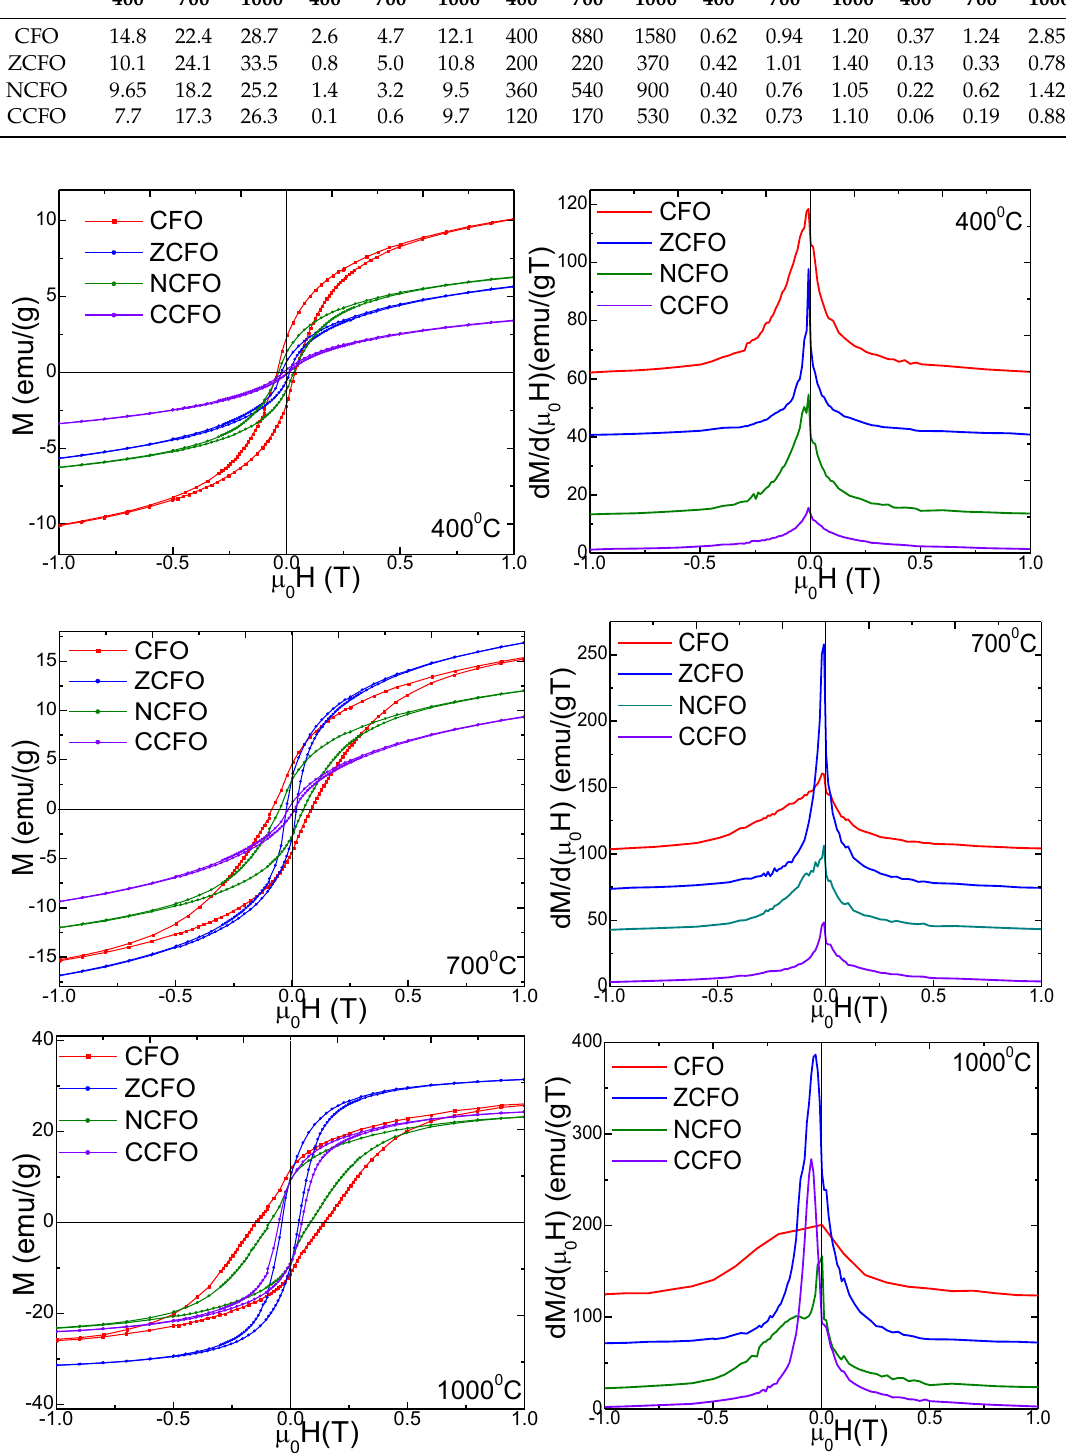
Figure 5. Magnetic hysteresis loops ( a ) and magnetization derivative ( b ) of CFO, ZCFO, NCFO, and CCFO annealed at 400, 700, and 1000 °C.